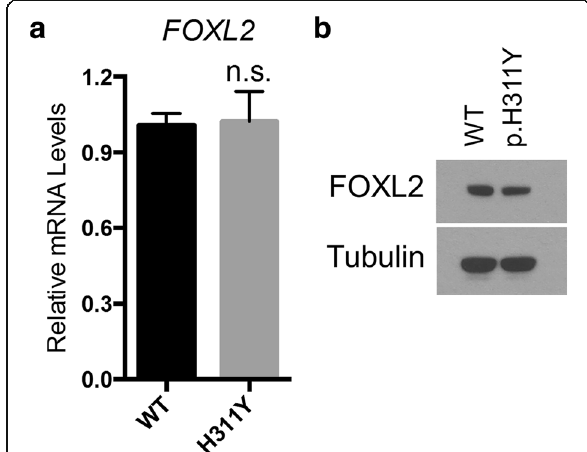
Fig. 2 Expression levels of WT and p.H311Y mutant FOXL2 . a . mRNA expression level of FOXL2 , as measured by qPCR, was comparable between WT and p.H311Y mutant. b . Protein level of FOXL2 , as determined by Western Blot, showed lower p.H311Y expression when compared to WT. n.s.: not significant